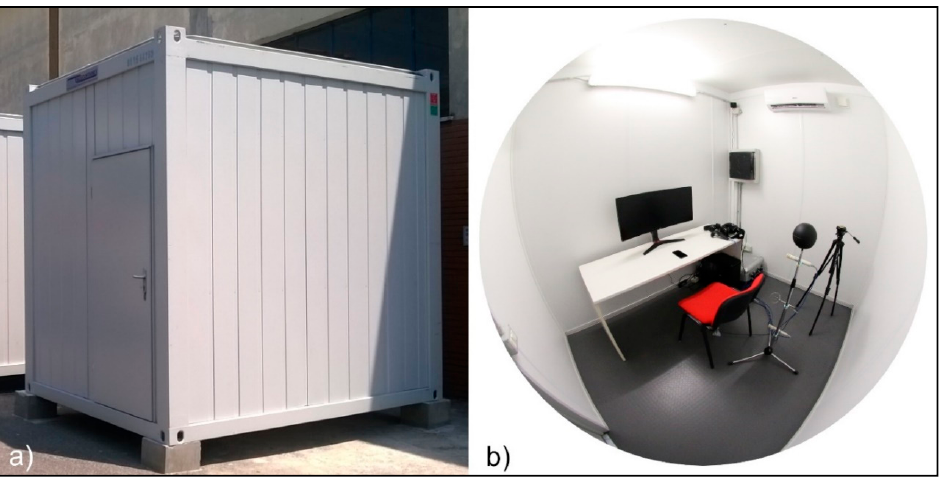
Figure 2. Test cell: ( a ) outdoor photo; ( b ) fisheye indoor photo.